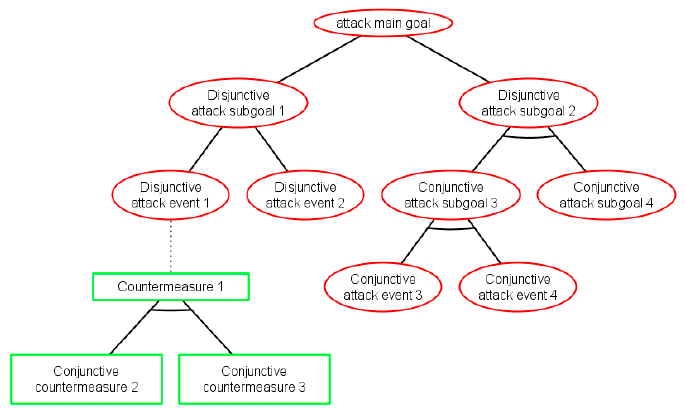
Figure 2. General structure of an attack defense tree (ADT).